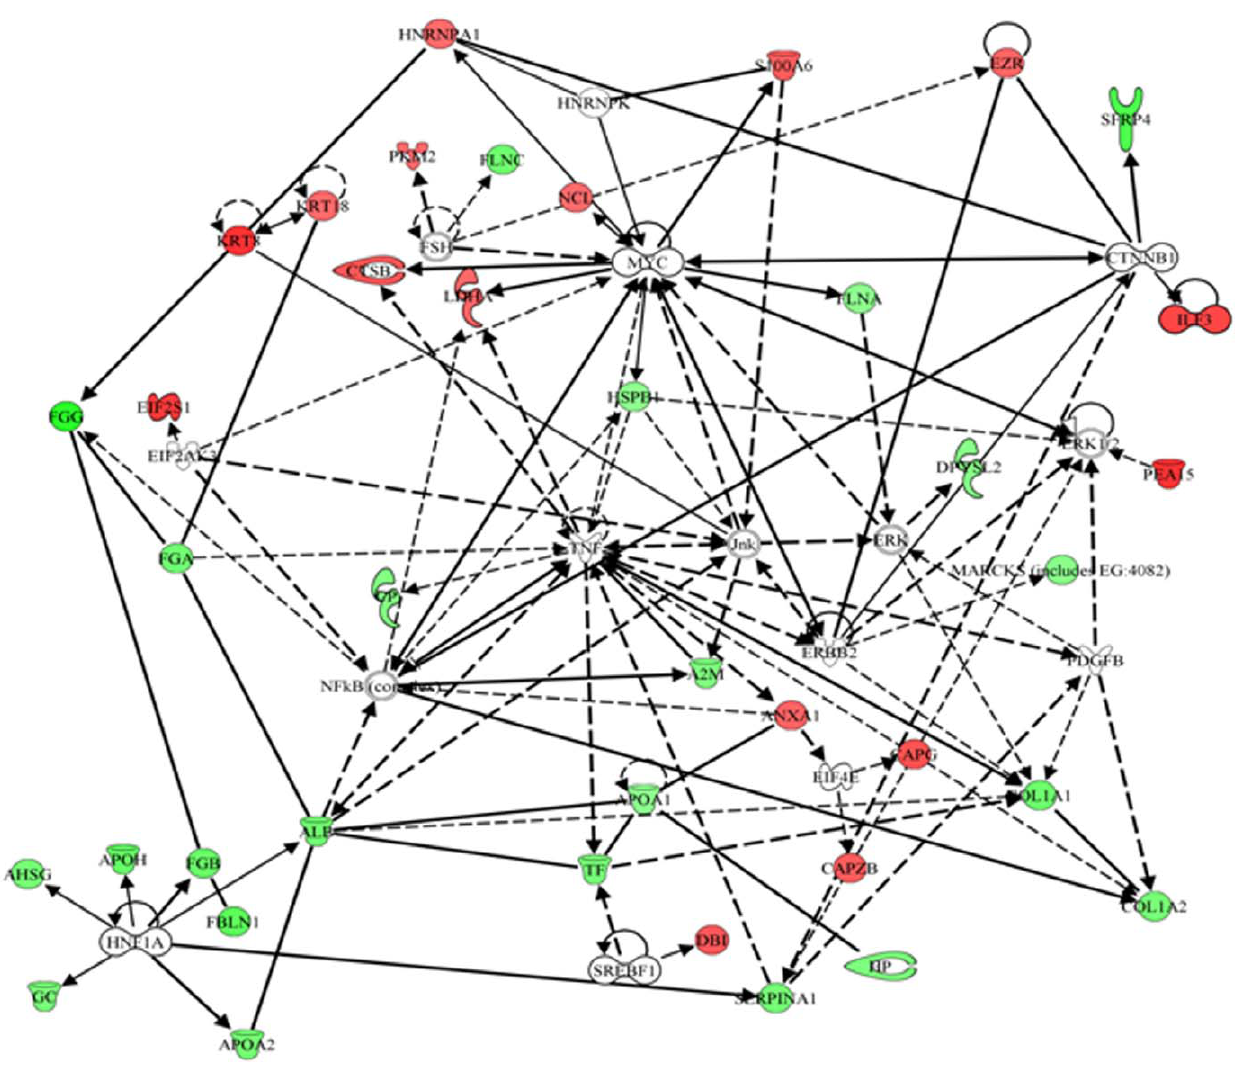
Figure 5. Network analysis. The potential novel molecular targets identified in this study were subjected to pathway analyses using Ingenuity Pathways Analysis (IPA) software, Version 7.5. The figure shows direct (bold lines) and indirect (dotted lines) regulations ( R )/interactions (--) among the biomarkers identified in this study and other significantly associated proteins. These networks reveal involvement of key proteins including TNF a , NF k B, c-myc, Her2/Neu, b -catenin, Jnk and Erk1/2 proteins that regulate inflammation, survival and proliferation.